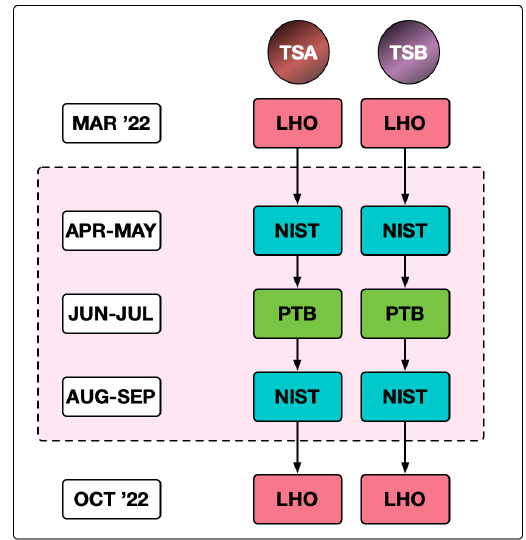
Figure 5. Schedule for the NIST:PTB bilateral comparison to be conducted in coordination with the LIGO Hanford Observatory (LHO) in preparation for the O4 observing run using the upgraded TSA and TSB power sensors.